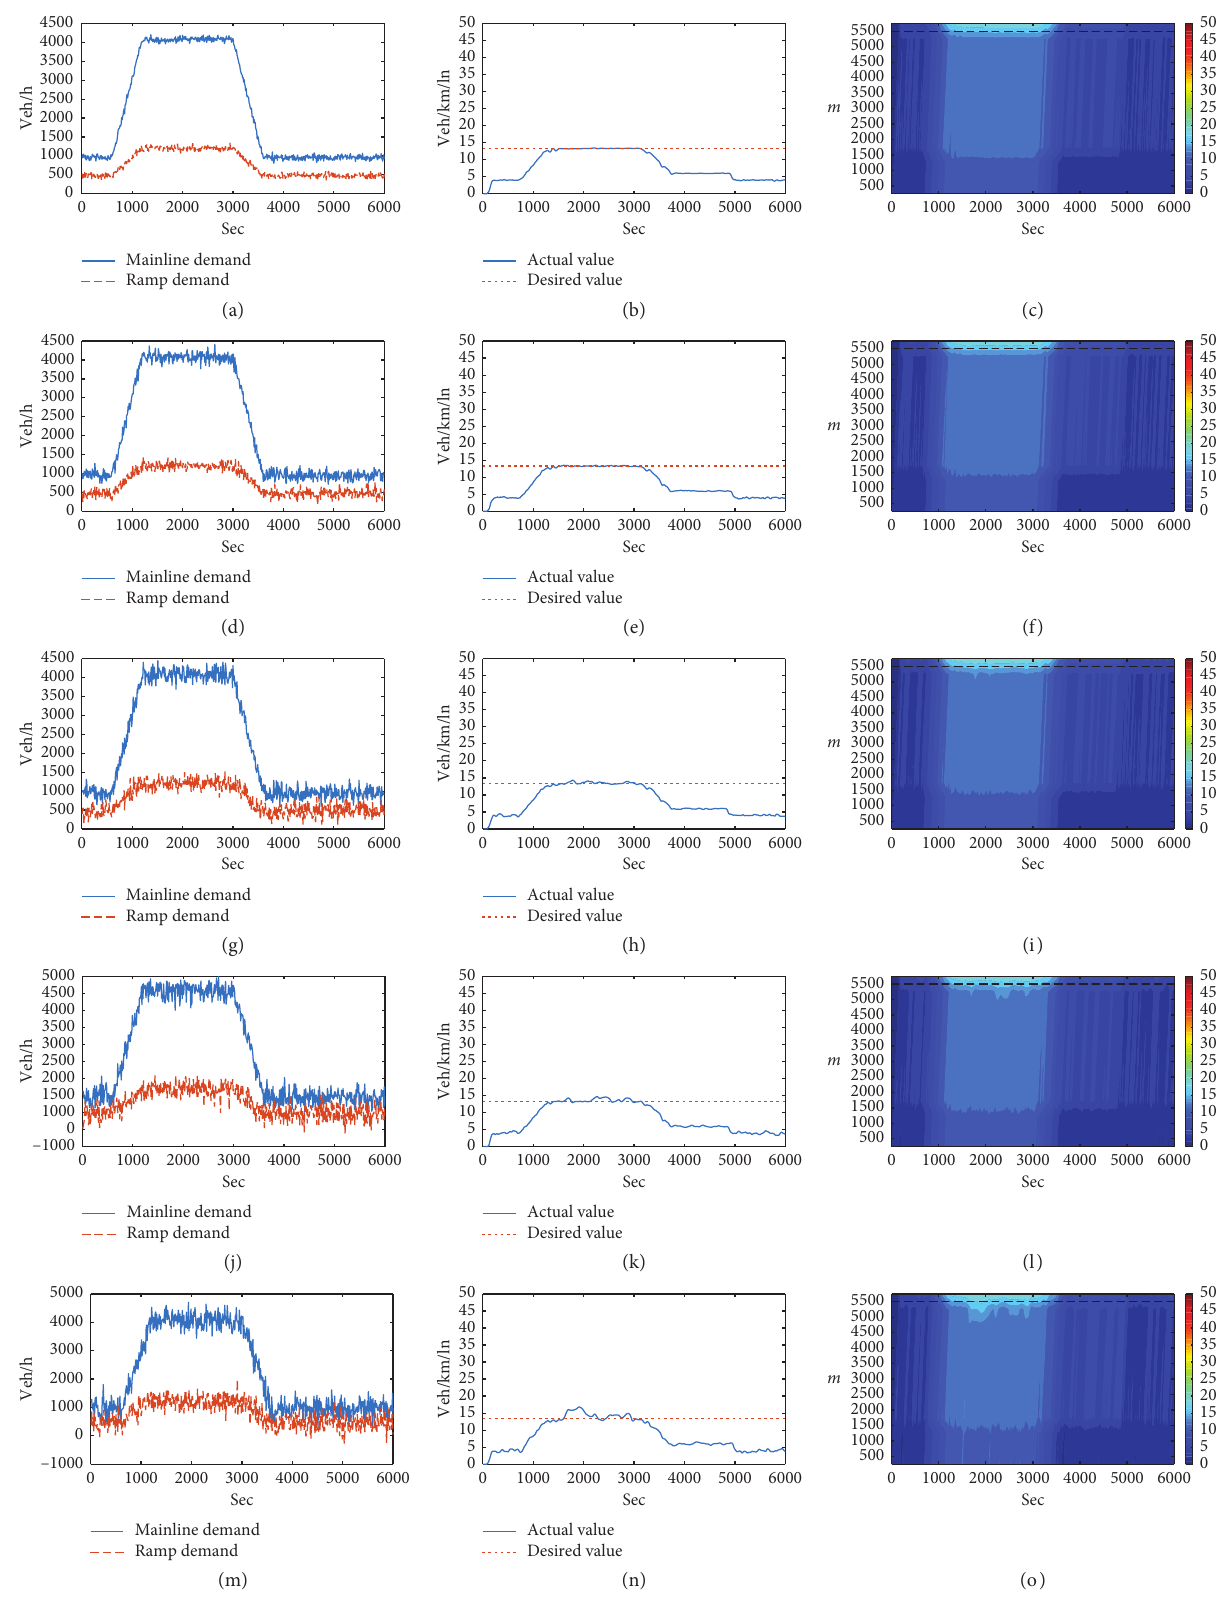
Figure 7: Performances of the ramp metering policy learned through the proposed approach under traffic demands with white noise. From the top row to the bottom row, the standard deviation of the white noise is 50, 100, 150, 200, and 250veh/h, respectively. The left column is traffic demands, the middle column is traffic density time series of the control target cell, and the right column is the traffic density contours of the entire